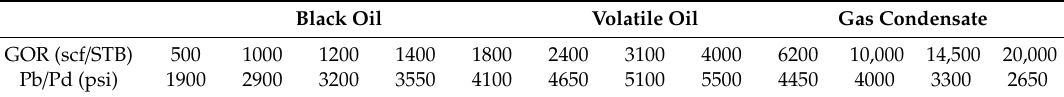
Table 1. Initial gas–oil ratios (GORs) and bubble-point pressures (Pb) or dew-point pressures (Pd) for Pb is for black oil and volatile oil fluids, whereas Pd is for gas condensate